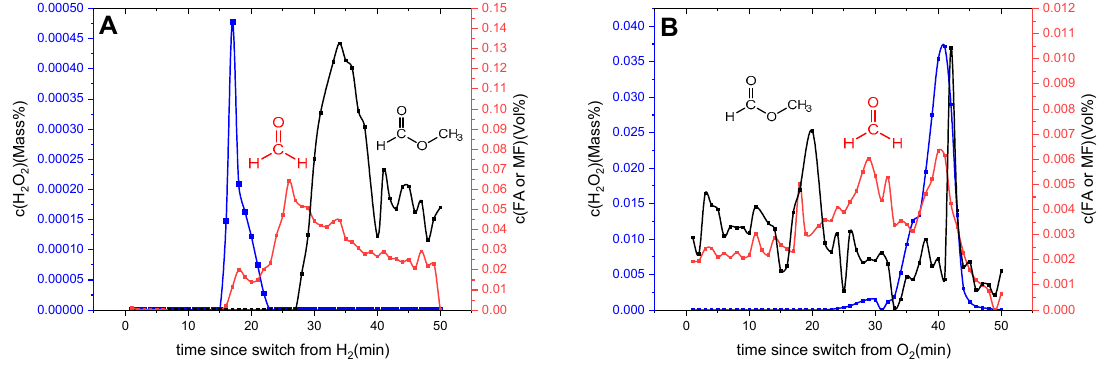
Figure 4. Transient responses of the hydrogen peroxide concentration, formaldehyde (FA) and methyl formate (MF) concentrations in methanol after the switch from ( A ) hydrogen-to-oxygen feed ( B ) oxygen-to-hydrogen feed.